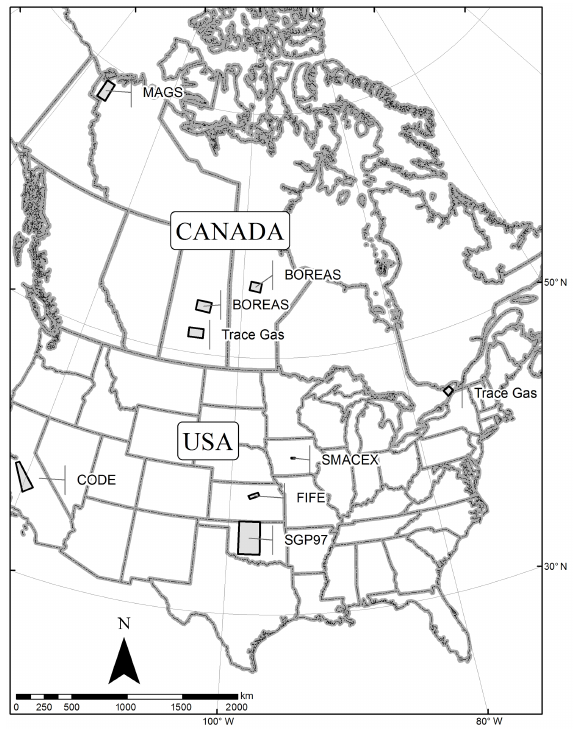
Figure 2. Location of measurement campaigns flown by the NRC Twin Otter,